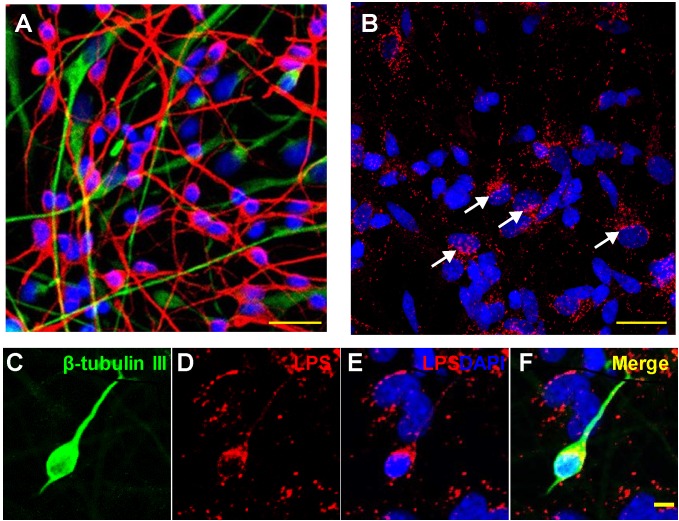
Association of lipopolysaccharide (LPS) with human neuronal-glial (HNG) cells in primary co-culture; (A) HNG cells are a primary co-culture of neuronal [β-tubulin III (βTUBIII)-stained; red; λmax = 690 nm] and glial (GFAP-stained; green; λmax = 520 nm) human brain cells; cells are also stained for nuclei (DAPI-stained; blue; λmax = 470 nm); cells shown are ∼2 weeks in culture; HNG cells are ∼60% neurons and ∼40% astroglia at ∼65% confluency; human primary neuronal and glial “support” cell co-cultures are utilized, because human neuronal cells do not culture well by themselves (Cui et al., 2010; Zhao et al., 2017b); HNG cells are electrically active and extremely sensitive to pro-inflammatory neurotoxins in the nM range (Lonza human cell systems; transplantation grade; Zhao et al., 2017b); yellow bar ∼20 um; HNG cells were exposed to 50 nM LPS for 36 h; (B) LPS (red; λmax = 690 nm) and nuclei (blue; λmax = 470 nm) stained HNG cells; four white arrows indicate perinuclear clustering of LPS as has been previously reported (Hill and Lukiw, 2015; Zhan et al., 2016, 2018; Yang and Chiu, 2017; Zhao et al., 2017a,c); panels (C–F) show details of LPS-neuronal cell interactions in a single neuron; LPS preferentially associates with neuronal nuclei and non-neuronal nuclei to a lesser extent (Zhao et al., 2017a,b,c; Zhao and Lukiw, 2018a,b); (C) β-TUBIII (green stain, λmax = 520 nm) is a neuron-specific stain; a single neuron is highlighted; (D) LPS (red stain; λmax = 690 nm) shows non-homogeneous clustering of LPS stain; (E) LPS (red stain; λmax = 690 nm) and DAPI-stained nuclei (blue stain; λmax = 470 nm) shows a “polarized” LPS affinity for the periphery of neuronal nuclei (see Zhao et al., 2017c); (F) merge of all signals; all yellow bars in (A–F) ∼20 um; LPS attraction for neuronal nuclei may be in part glial-cell modulated; there is recent evidence that perinuclear LPS may disrupt the normal transcriptional output of human neuronal nuclei for neuron-specific components such as the neurofilament light chain (NF-L) protein (Lukiw et al., 2018; Zhao et al., 2019).